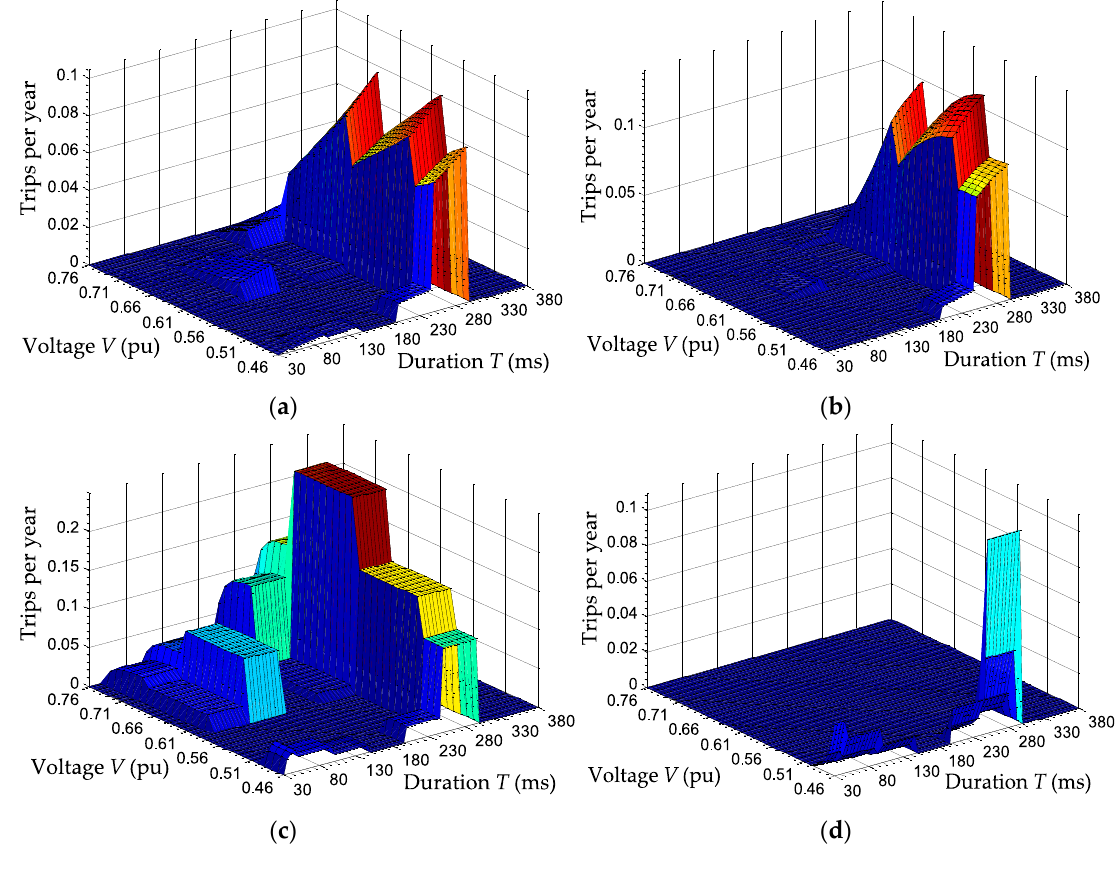
Figure 22. Number of expected trips per year of various voltage–tolerance characteristics for PLC: Cumulative probability method ( a ) uniform; ( b ) normal; ( c ) exponential; and ( d ) reverse exponential. Table 9. Comparison of estimated total number of PLC trips per year.